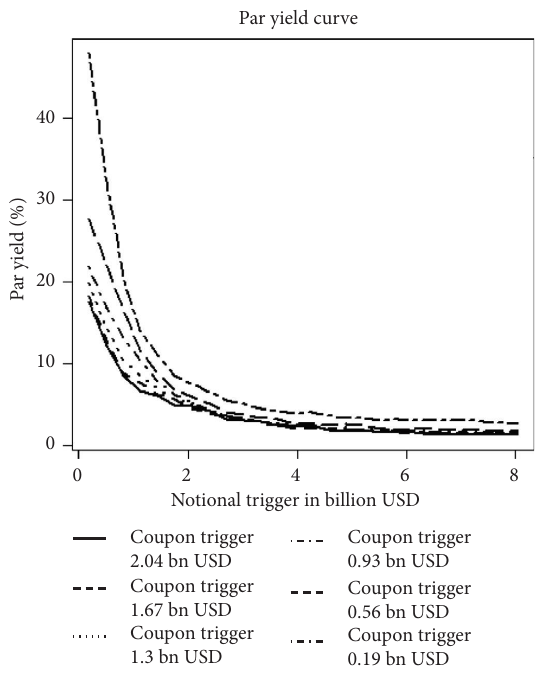
Figure 22: Cyber bond par yield